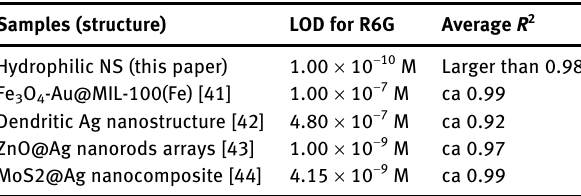
Table  : ComparisonsoftheLODandaverage R  forthirambetween hydrophilic CuO@ZnO@Ag NS and other samples. Samples (structure)